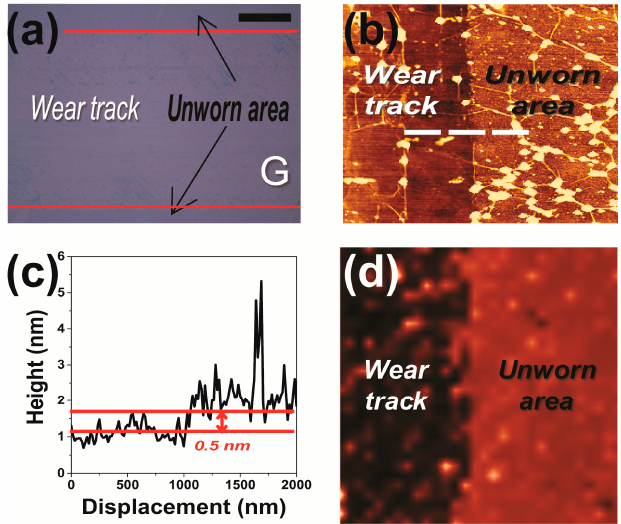
Figure 3. Wear track images of the graphene sample subjected to low pressure and 10 cycles of sliding. ( a ) Optical image (dotted line indicates the boundary between wear track and unworn area), ( b ) AFM image, ( c ) surface height profile along the dotted line in ( b ), and ( d ) Raman spectrum image (2D peak). Black scale bar, 10 µm.